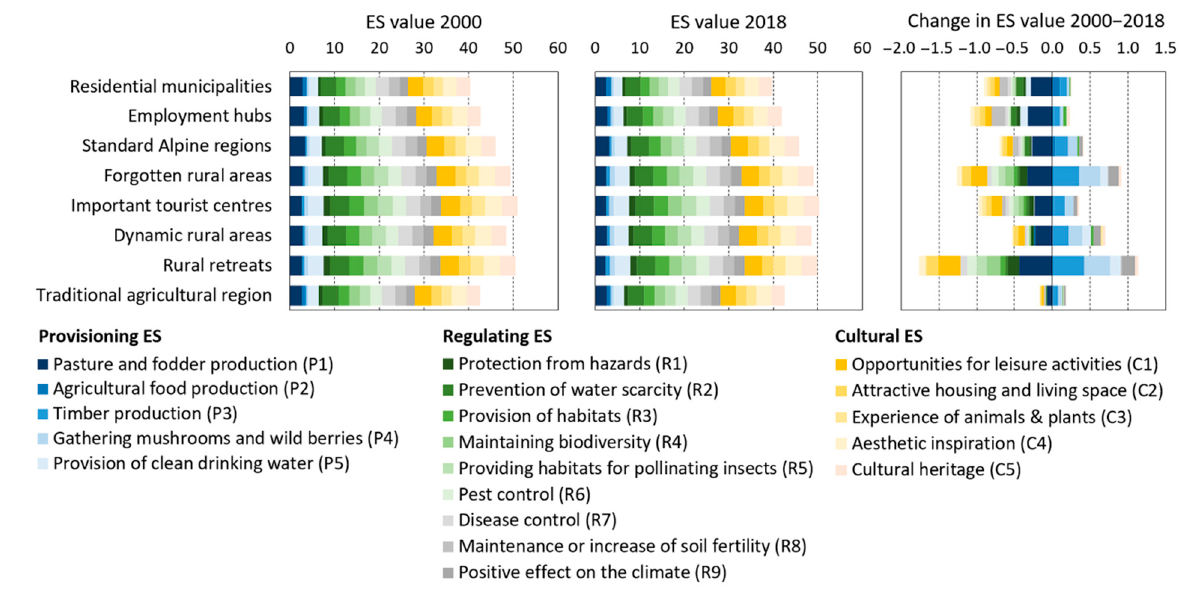
Figure 4. ES values in 2000 ( left ), 2018 ( center ), and change in ES value between 2000 and 2018 ( right ). Authors own elaboration.